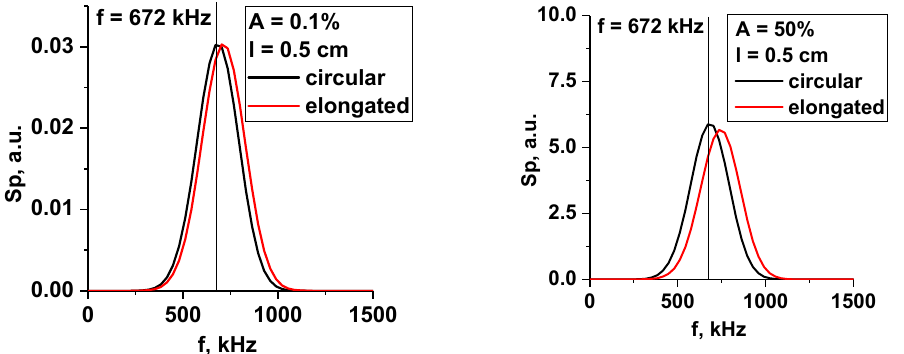
Figure 25. Spectrum of DBS signals for the 0.5 cm filament: ( left ) filament amplitude of 0.1% of density at cutoff of the probing wave 48 GHz where the filament was positioned; ( right ) amplitude of 50%. The black lines correspond to the circular filament, and the red lines correspond to the radially stretched filament.